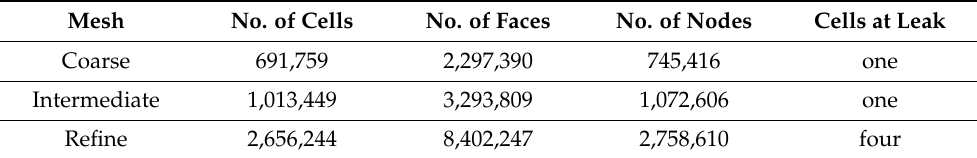
Table 2. Mesh details for grid independence study.